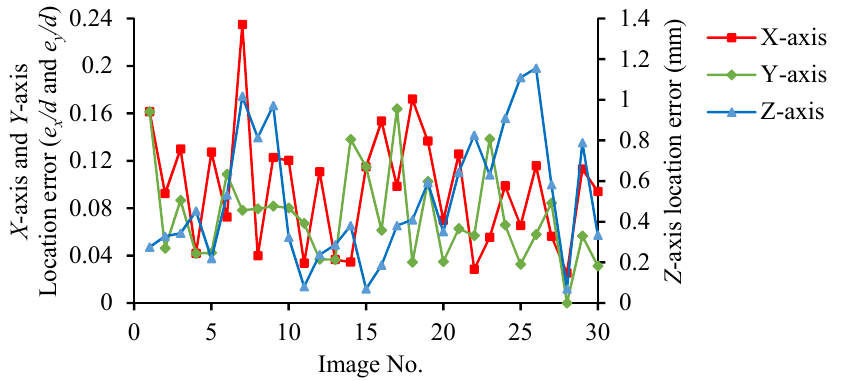
Figure 16. The location error of the laser strike point on the X -axis, the Y -axis, and the Z -axis. d denotes the pixel width of the P. rapae body in images of different scales. The location error is represented by the ratio of the x coordinate, y coordinate deviation ( e x , e y ) and d